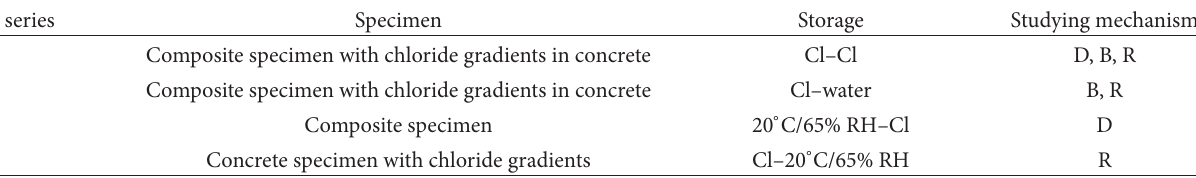
Table 1: Laboratory storage tests.